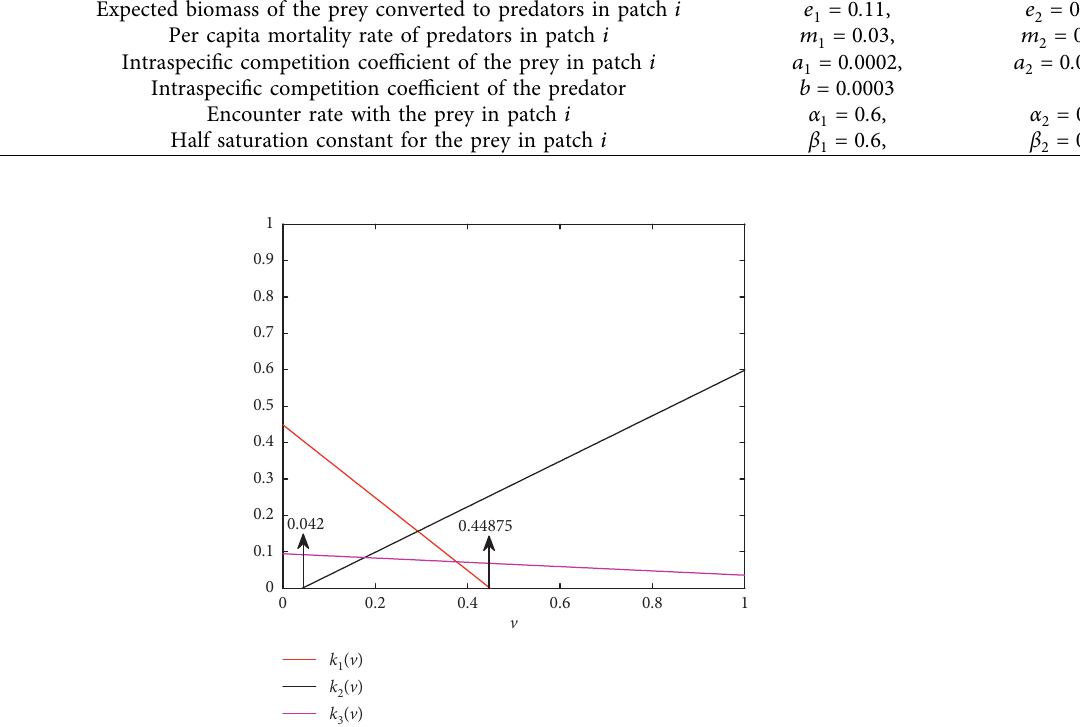
Figure 1: The trajectories of k